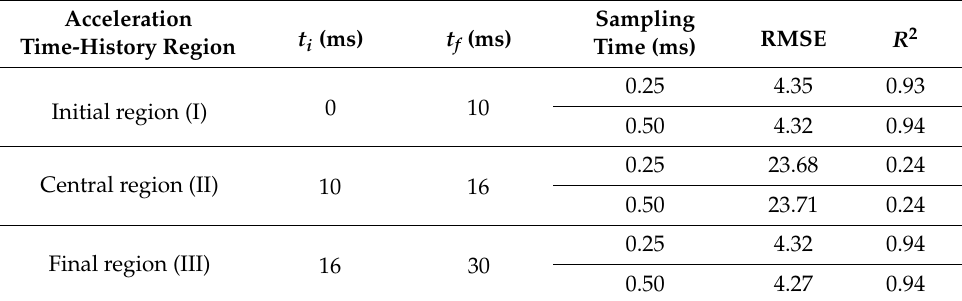
Figure 7. Comparison between the acceleration curve predicted by the simulation and the experimental curve for the EVA 50 mm at 5.2 m/s. Table 3. Statistical analysis of the missile acceleration curve for the EVA 50 mm at 5.2 m/s.